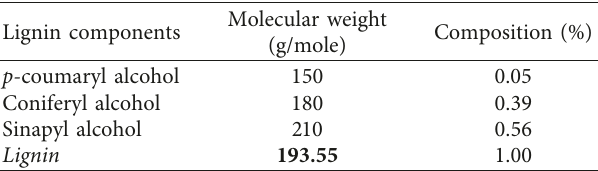
Figure 4: DSC analysis. Sample (25mg); powder (38 μ m); N Table 1: Lignin composition.